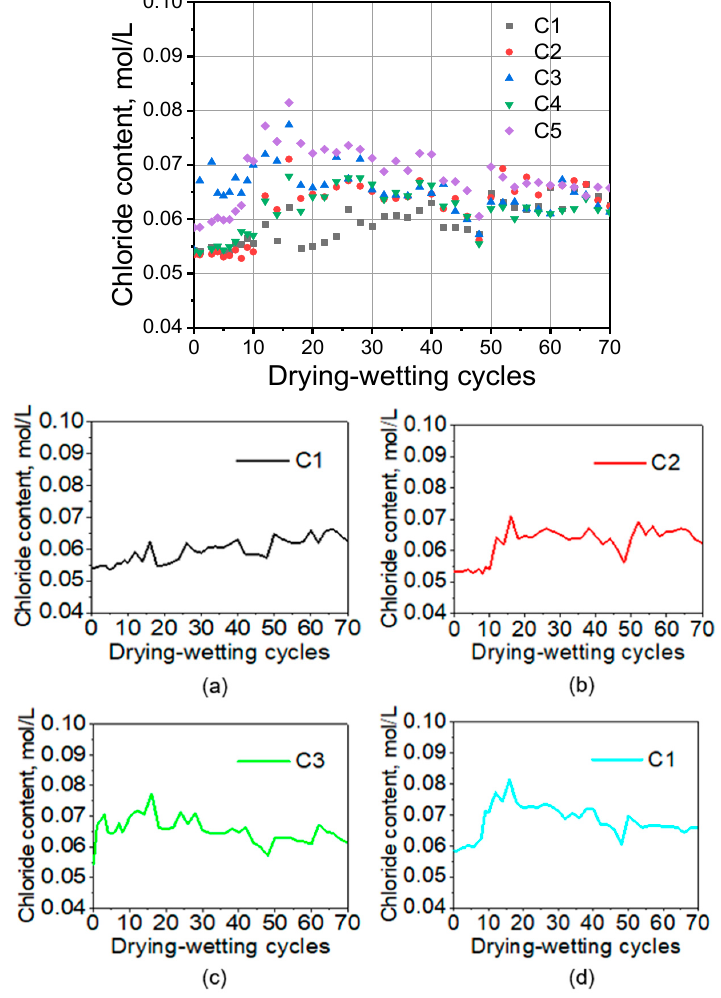
Figure 6. Chloride concentration calculated by Nernst’s law with the absence of temperature correction .